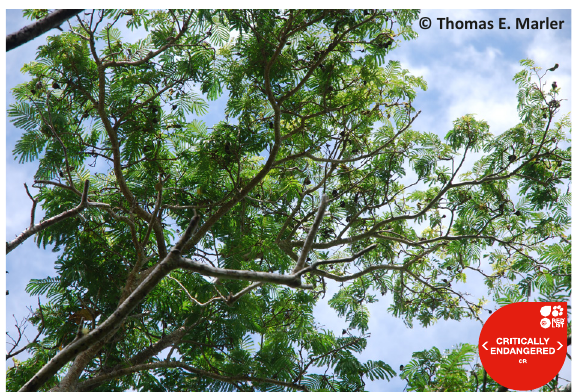
Image 1. The canopy of a mature Serianthes nelsonii tree exhibits fine-textured foliage and retained dried